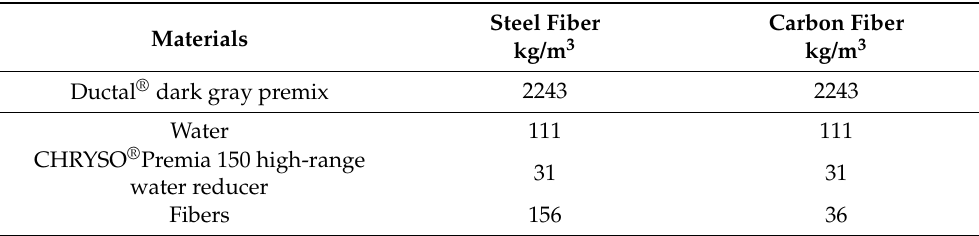
Table 1. UHPC mix design for steel and carbon fibers in units of kg of material per cubic meter of concrete.